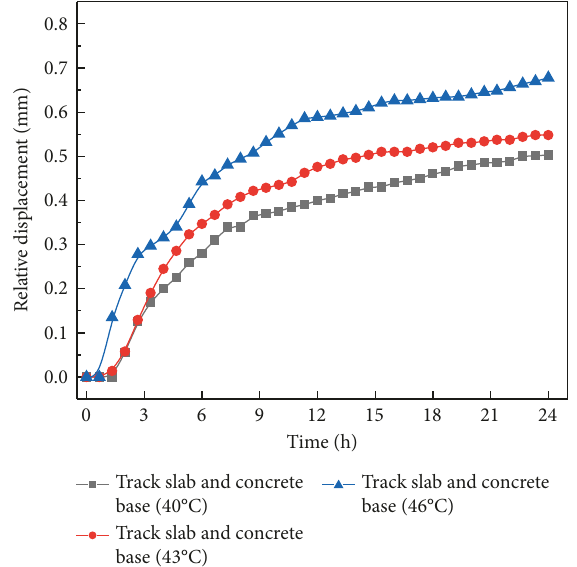
Figure 11: The relative longitudinal displacement of the freedom specimen.